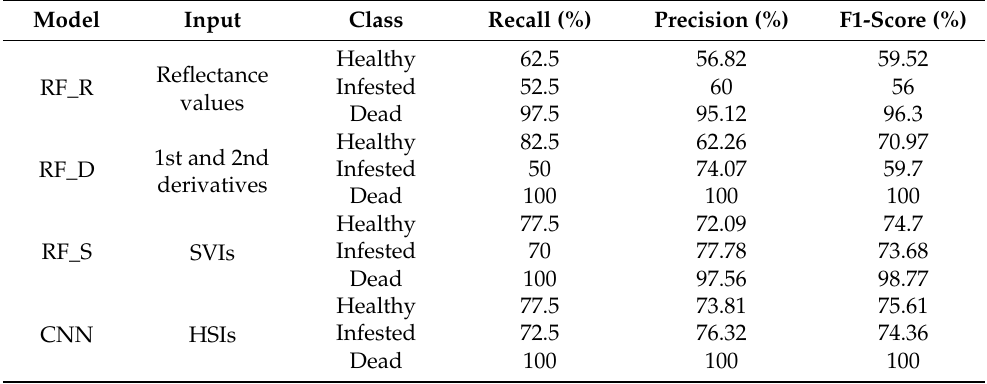
Table 4. Evaluation metrics for each infestation